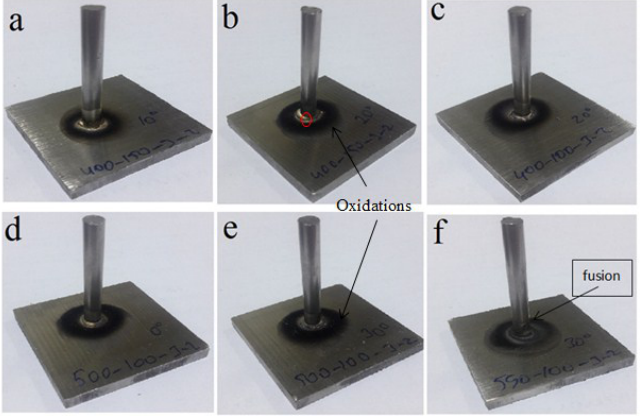
Figure 1. Macroscopic views of welded specimens with varying parameters: ( a ) 400-0.15-3-2-10°; ( b ) 400-0.15-3-2-20°; ( c ) 400-0.10-3-2-20°; ( d ) 500-0.10-3-2-0°; ( e ) 500-0.10-3-2-30°; and ( f ) 550-0.10-3-2-30°.